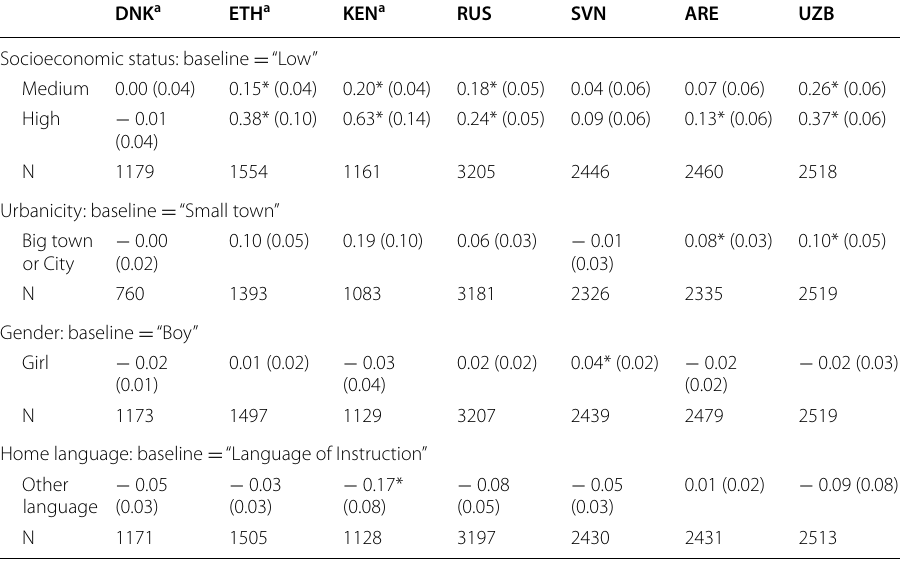
Coefficients for groups come from separate regressions. Standard errors shown in parentheses. Probability weights have been applied and jackknife standard errors have been calculated in all countries except in Denmark, Ethiopia, and Kenya. In Denmark, Ethiopia, and Kenya standard errors have been clustered by